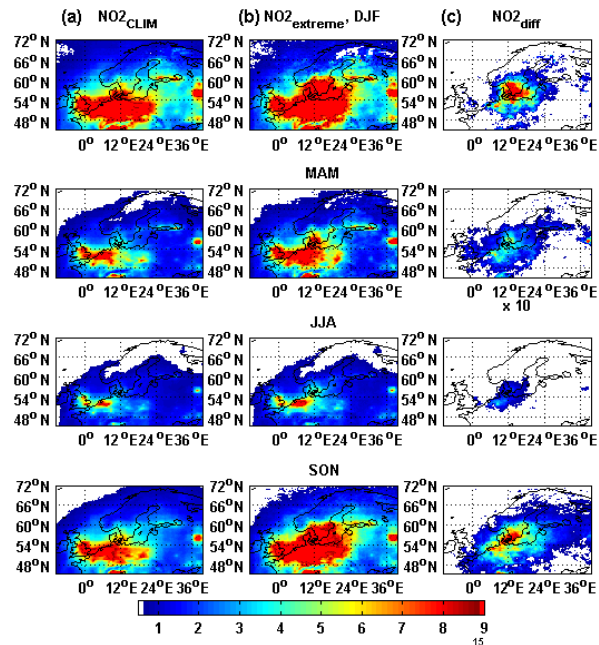
Figure 3. Seasonal, climatological average tropospheric NO 2 total column (a) based on nearly 11-year OMI data (2004–2015), NO 2 distribution during extreme events (b) and the difference between the two (c) . The units are in moleculescm − 2